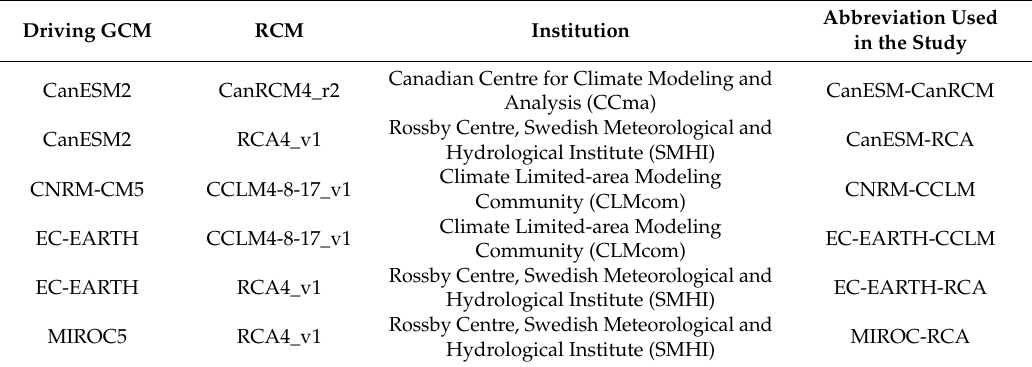
Table 1. Applied Regional Climate Models (RCMs), their driving Global Climate Models (GCMs), and their corresponding abbreviations used in this